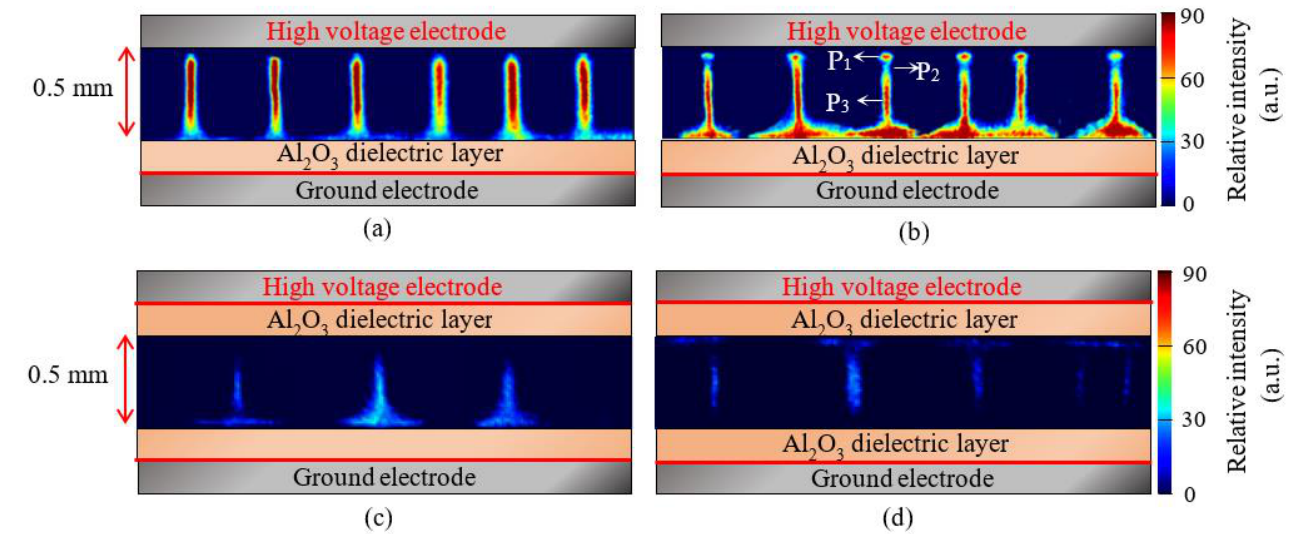
Figure 4. Typical discharge images in different cycles: ( a ) SDBOR in the positive half-cycle; ( b ) SDBOR in the negative half-cycle; ( c ) DDBOR in the positive half-cycle; ( d ) DDBOR in the negative half-cycle, (applied voltage = 2.8 kV, discharge gap = 0.5 mm, exposure time = 1 μ s).